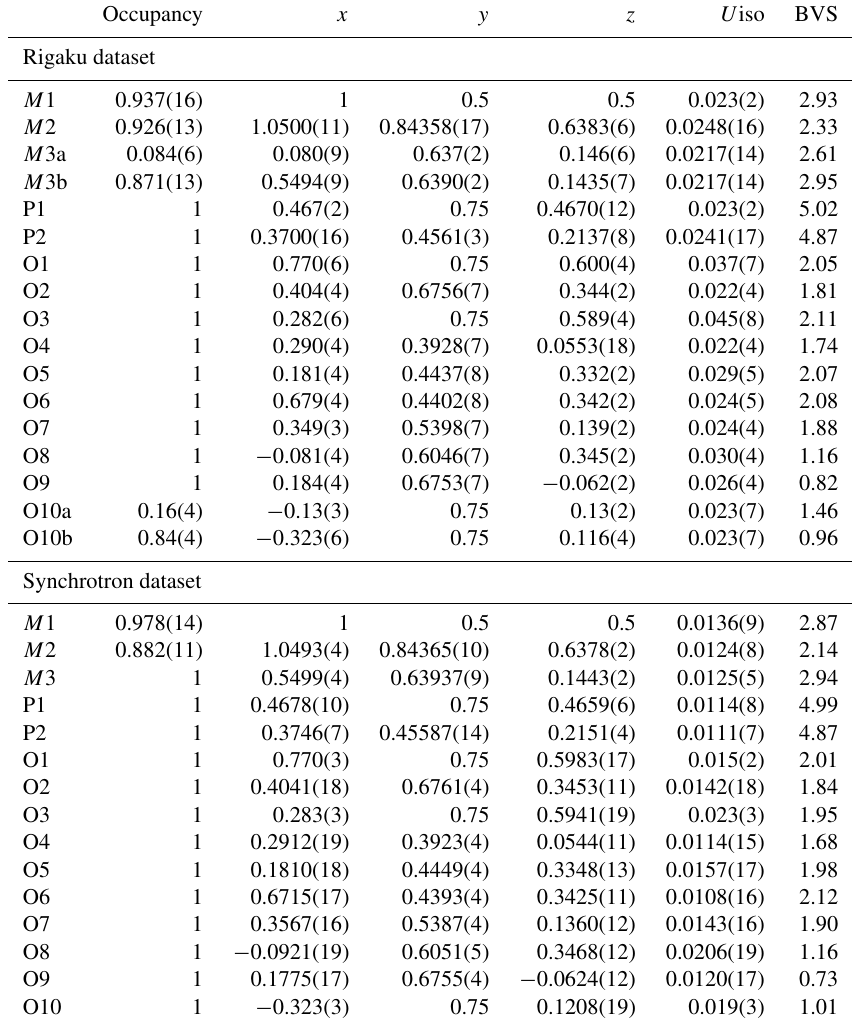
Table 5. Fractional atom coordinates, isotropic displacement parameters (Å 2 ) , site occupancies and bond valence sums (BVSs, valence units) for